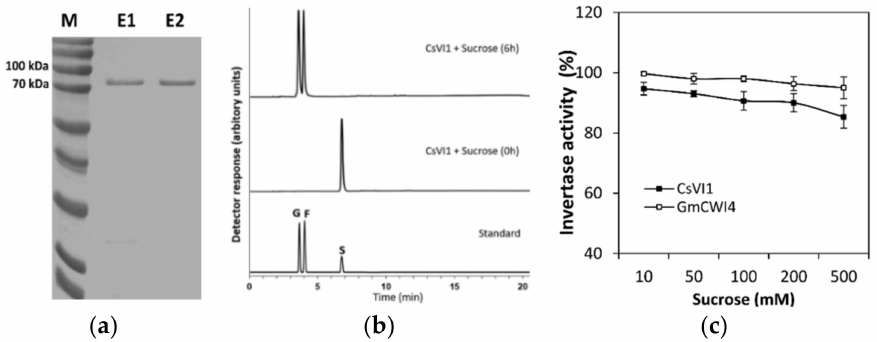
Figure 8. Detection of CsVI1 enzyme activity. ( a ) SDS-PAGE analysis of recombinant CsVI1 protein from Pichia pastoris . Marker (M), elution fractions (E1–2) in 100 mM imidazole. ( b ) Analysis of INV enzyme activity of recombinant CsVI1 (20 µ g) with sucrose (50 mM) as a substrate. ( c ) Comparison of INV enzyme activities between recombinant CsVI1 and the previously identified acid invertase GmCWI4. Sucrose (10–500 mM) was incubated with the recombinant proteins (20 µ g). The fructose and glucose liberated from sucrose were measured using HPAEC-PAD. The standards used for HPAEC-PAD included: G, glucose; F, fructose; and S, sucrose. The term “invertase activity %” means percentage of sucrose hydrolyzed. Results are means of >3 biological replicates ( ± SE) each with three technical